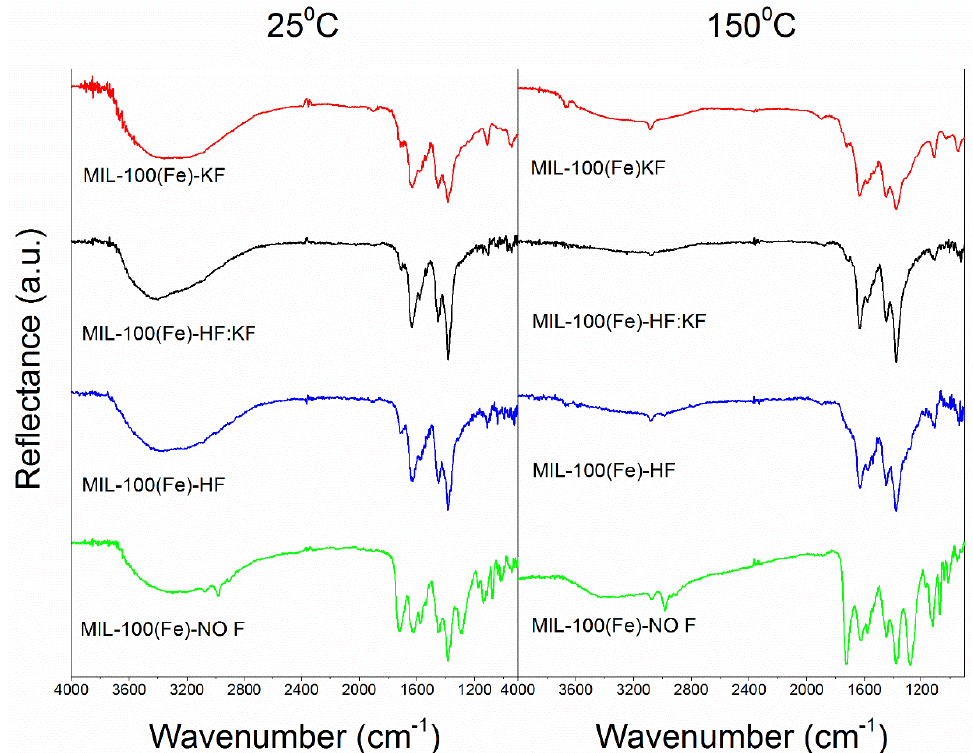
Figure A1. FT-IR spectra of MIL-100(Fe) samples after synthesis and after treatment at 150 °C in inert atmosphere.